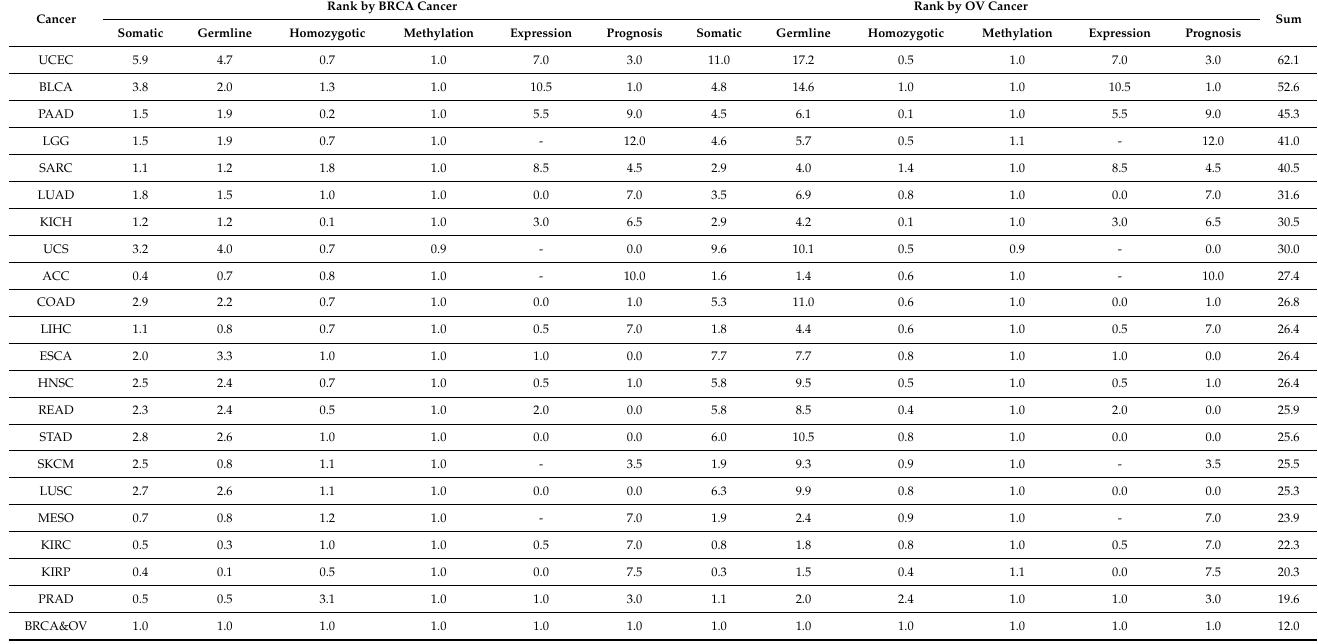
Table 1. The 21 candidate cancer types for PARPi test as referred by both BRCA cancer and OV